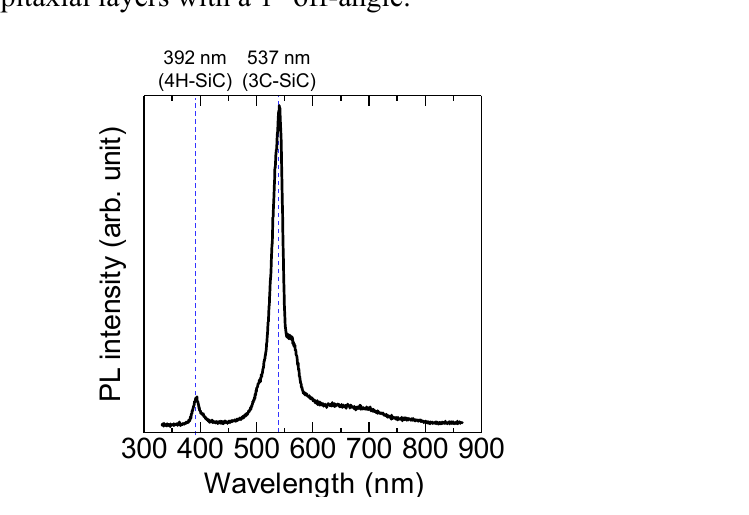
Figure 2. Photoluminescence (PL) spectrum recorded on the surface defect generated in the 4 H -SiC Si-face epitaxial layers with a 1°